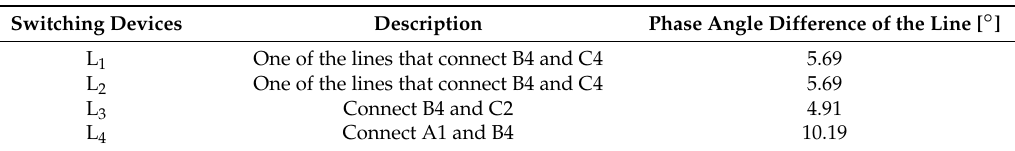
Table 2. Switching devices in Case 1.